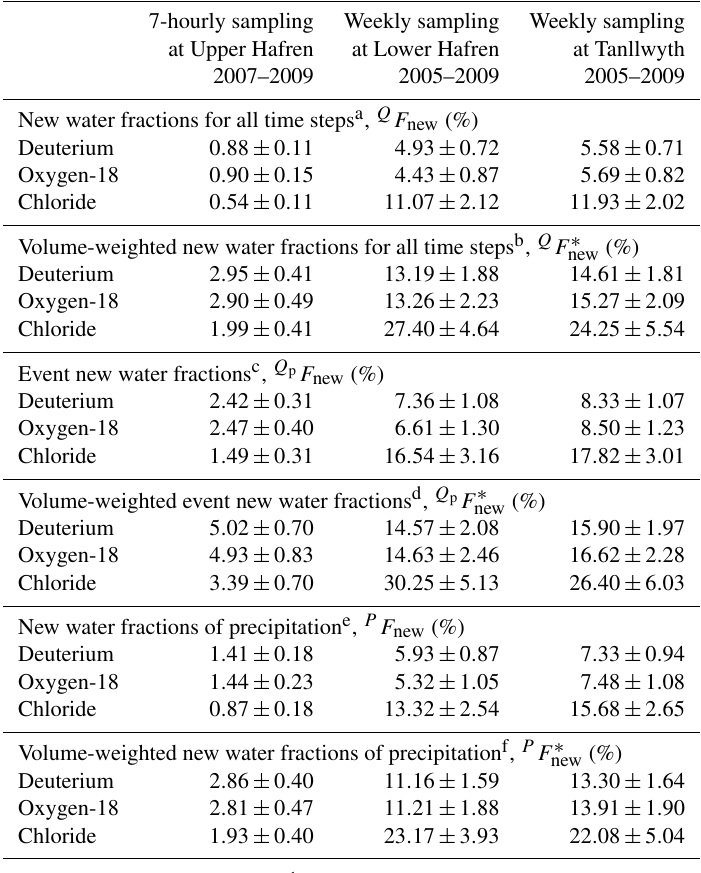
Table 1. New water fractions ( ± standard errors) calculated from 7-hourly and weekly measurements of deuterium, oxygen-18, and chloride (chloride time series at 7-hourly resolution were corrected for dry deposition before the calculation of new water fractions). From top to bottom: new water fractions calculated using all time steps, event new water fractions calculated from time steps with precipitation, and new water fractions of precipitation, each calculated with and without volume-weighting. New water fractions cannot be directly compared between the two sampling